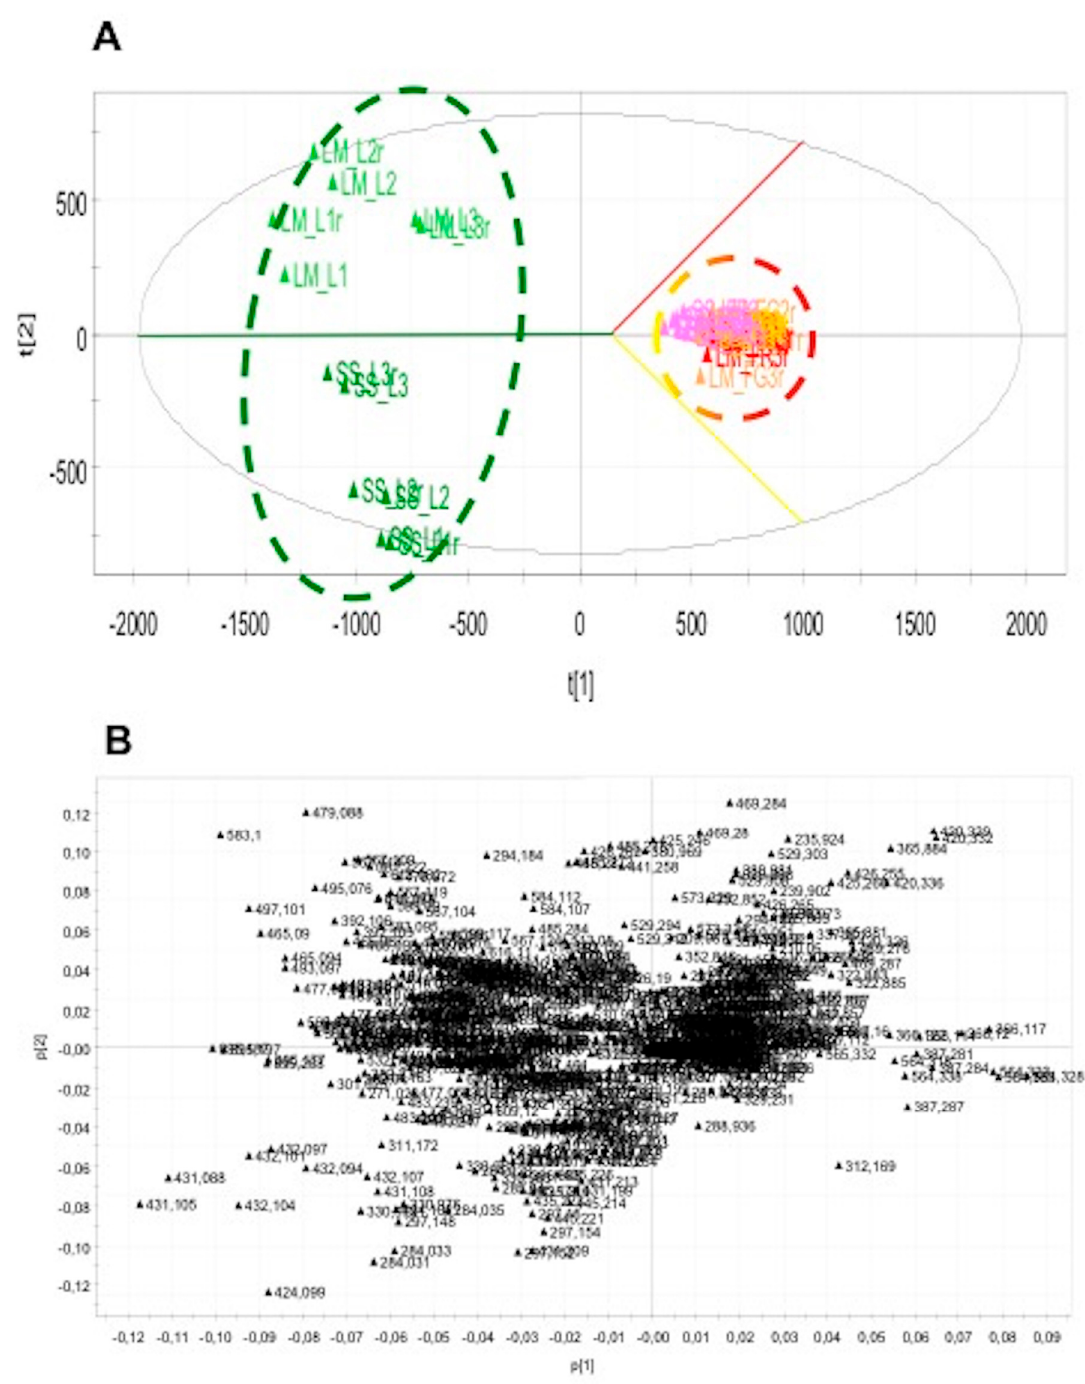
Figure 4. Score plot ( A ) and loading plot ( B ) obtained from HR–LCMS data. (L = Leaves; FR = Red Fruit; FG = Yellow Fruit; SS = Sassari; LM = La